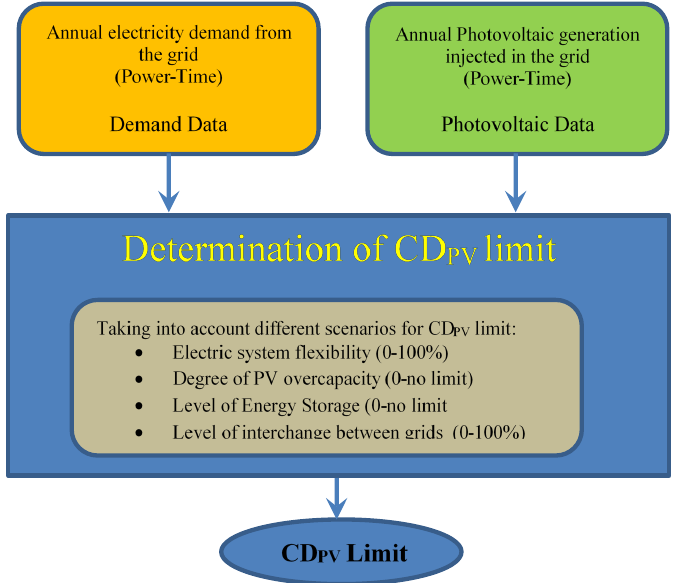
Figure 1. Methods used in the literature to estimate the limit of the coverage of electricity demand by means of PV’s. As it can be seen, different scenarios can be considered.